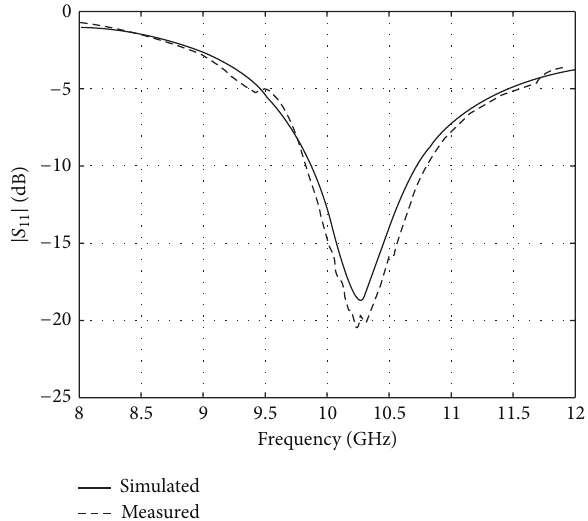
Figure 9: Simulated and experimental 𝑆 11 responses of the ferrite loaded MPA.